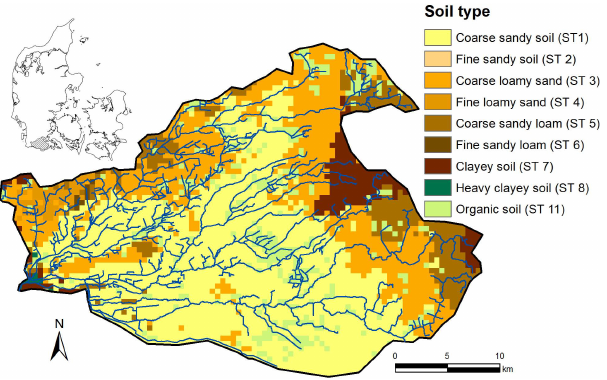
Fig. 1. Map showing the distribution of soil types in the